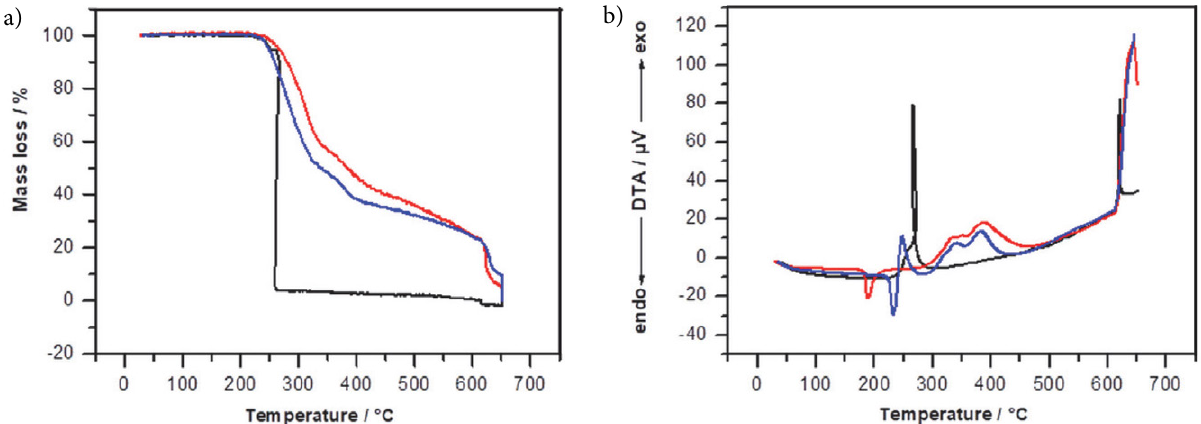
Figure 2. a. Thermogravimetric curves at 15 °C min –1 heating rate, b. DTA curves [black: N -(5-chloro-2,4-dinitrophenyl)hydrazine ( 1 ), blue: N -(5-chloro-2,4-dinitrophenyl)guanidine ( 2 ), red: N -(5-chloro-2,4-dinitrophenyl)-4-aminopyrazole ( 3